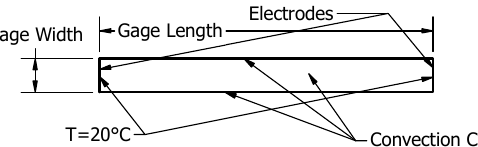
Figure 3. Boundary conditions used in numerical simulation. Convection cooling also applied on opposite